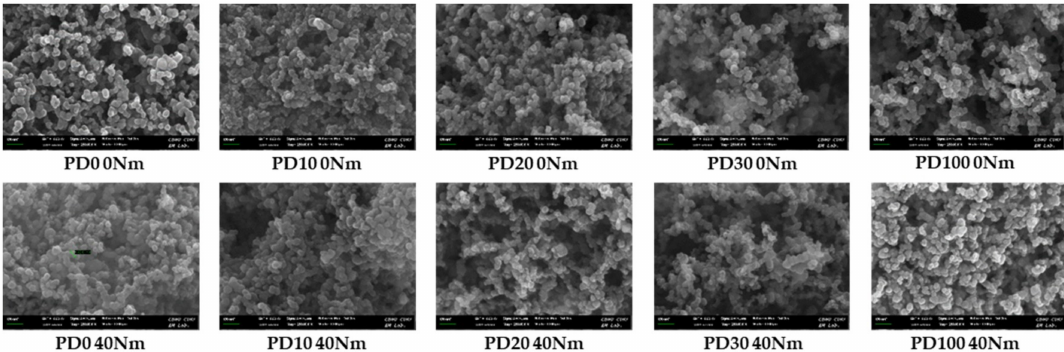
Figure 10. SEM images for various test fuels and engine loads (pilot BTDC 20 ◦ CA).